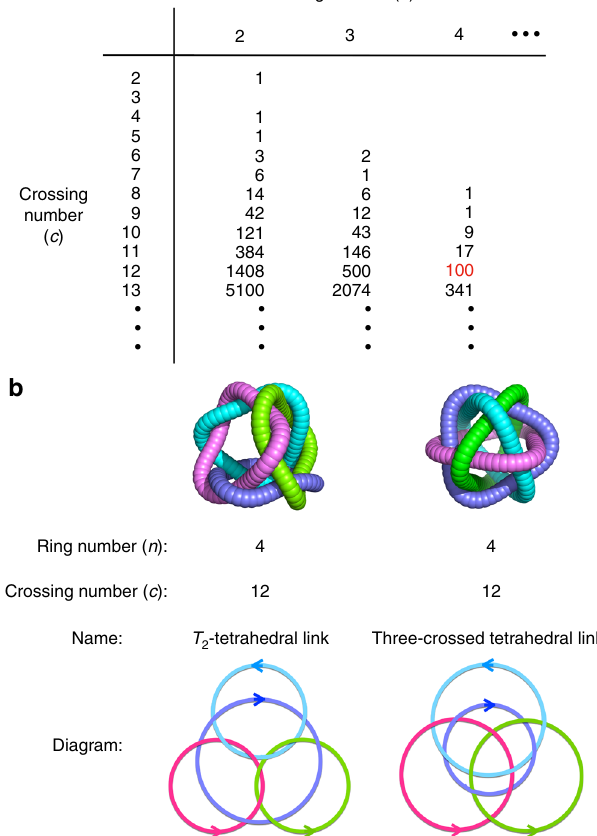
Fig. 1 Number of topologies and overview of the two [4] 12 -catenane topologies discussed in this work. a Number of possible topologies corresponding to ring number ( n ) and crossing number ( c ) in the case of prime, unoriented, alternating links 2 . b Name and diagram of two topologies of ( n , c ) = (4, 12) constructed in this work. Since each of these links has a reduced alternating link diagram 1 of 12 crossings, its crossing number is exactly 12. Each ring has a directional sense, which is de fi ned by the N → C direction within each peptide ligand